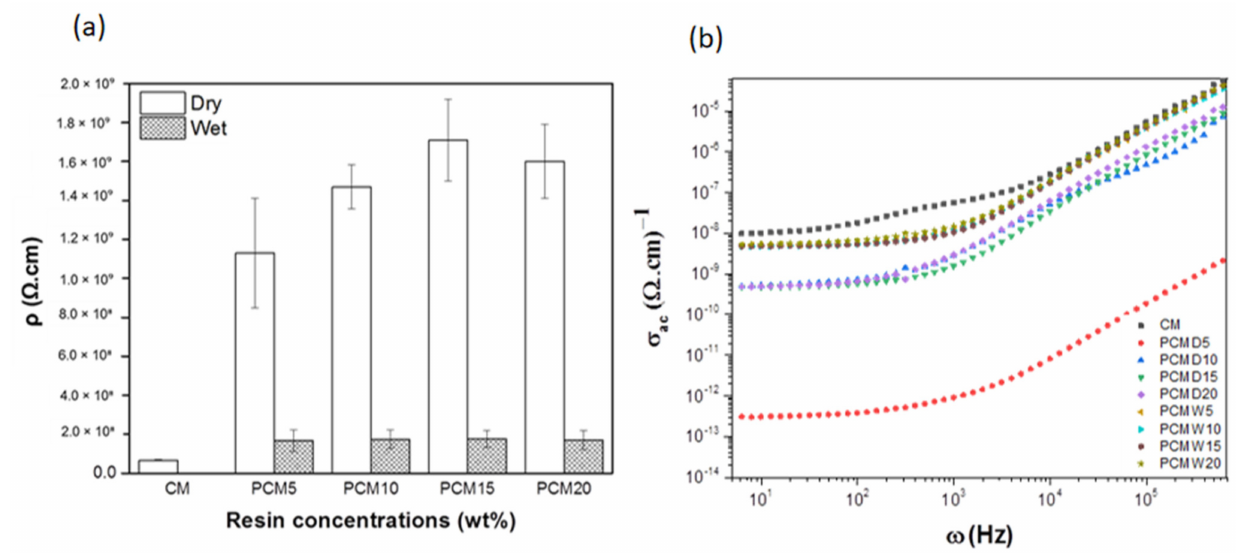
Figure 10. ( a ) Resistivity of PCMW and PCMD materials at different resin concentrations and ( b ) frequency-dependent AC conductivity of CM and PCM